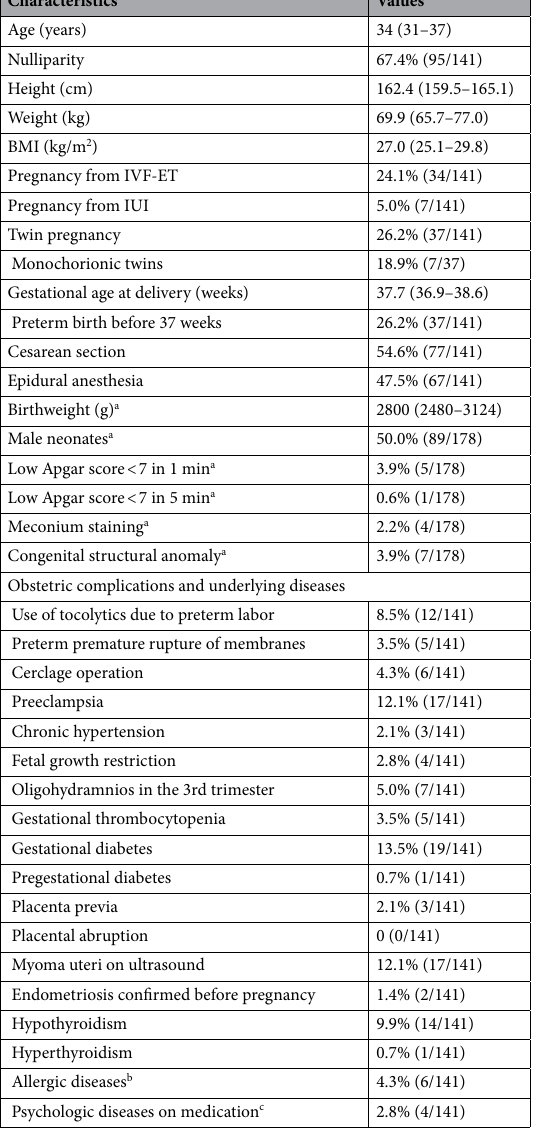
Table 1. Clinical characteristics of the study population. BMI, body mass index; IVF-ET, in-vitro fertilization and embryo transfer; IUI, intrauterine insemination. Values are expressed as the median (interquartile range) for continuous variables and percentage for categorical variables. a The denominator is the number of newborns. b Asthma for three cases, allergic rhinitis, angioedema, and cholinergic urticaria. c Major depressive disorder for two cases, anxiety disorder, and panic